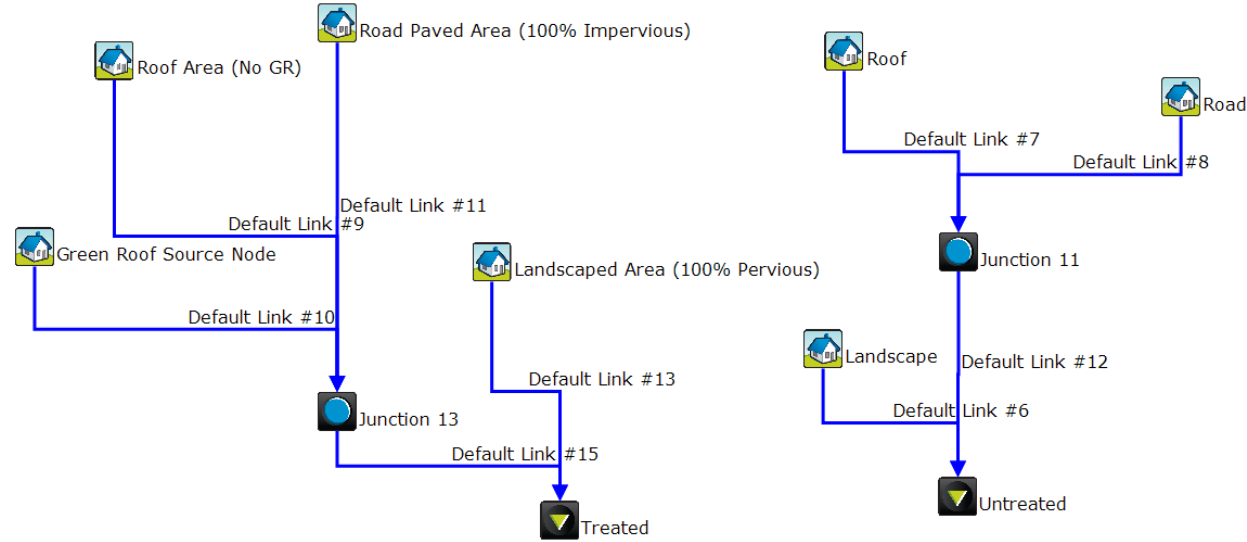
Table 6. Soil characteristics for the green roof in MUSIC’s bioretention node.